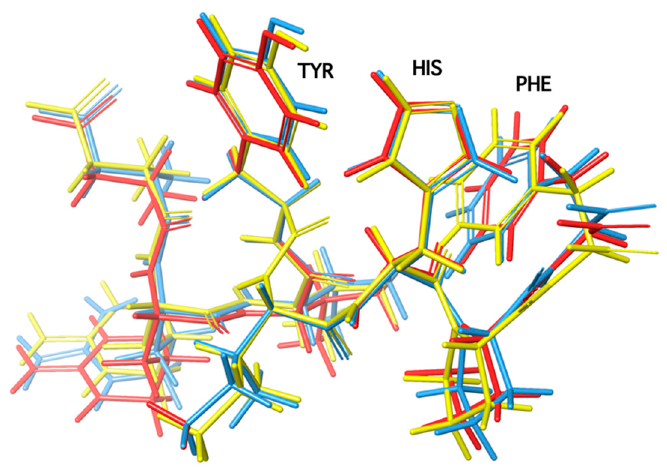
Figure 3. Putative bioactive conformation of angiotensin II based on NMR spectroscopy and molecular dynamics.